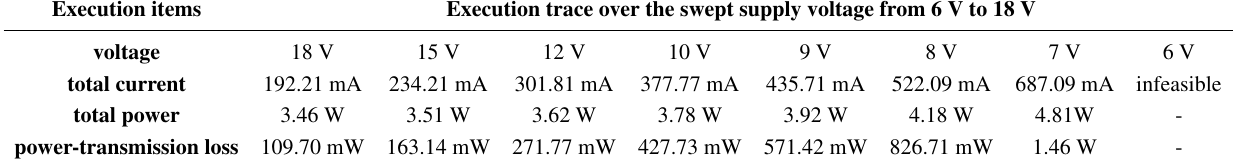
Table 1. Total current and power consumed by the tree example in Figure 5 over different supply